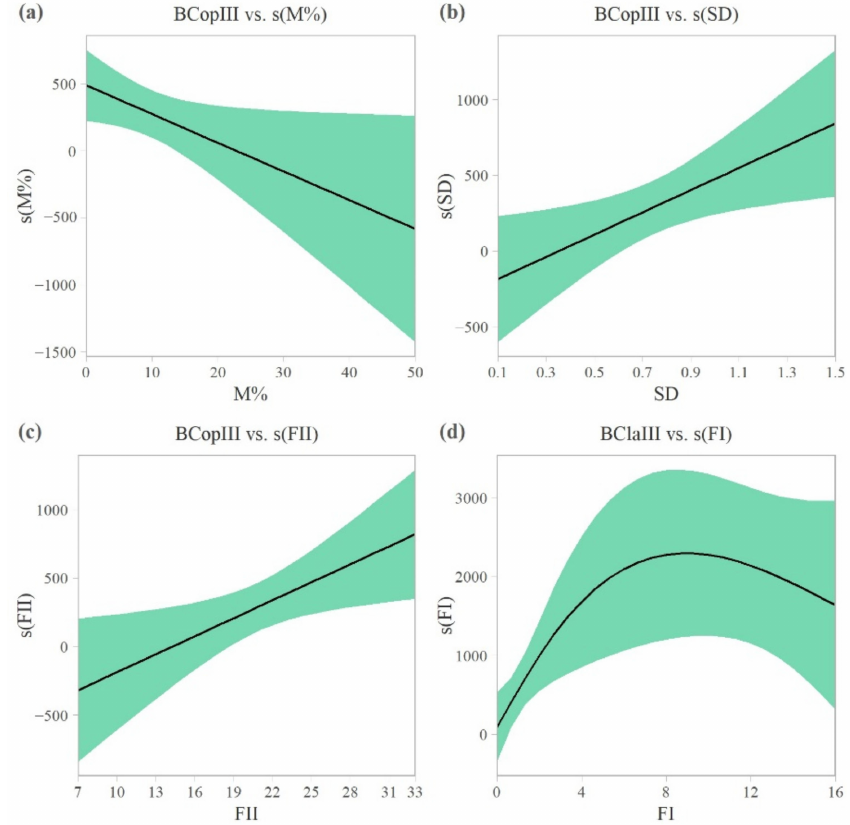
Figure 7. Generalized additive model (GAM) plots showing the partial effects of the four selected independent variables (FI, FII, M%, and SD) on BClaIII and BCopIII abundance. Y-axis indicates the partial effect of the variable and shaded areas represent the 95% confidence intervals. ( a ) Abundance of large size copepods (BCopIII) vs. percentage macrophyte coverage (M%). ( b ) Abundance of large size copepods (BCopIII) vs. Secchi disk transparency (SD). ( c ) Abundance of large size copepods (BCopIII) vs. abundance of medium-sized fish (FII). ( d ) Abundance of large size cladocerans (BClaIII) vs. small sized fish (FI). Abbreviations: BClaIII—large-sized Cladocera in benthal; BCopIII—large- sized Copepoda in